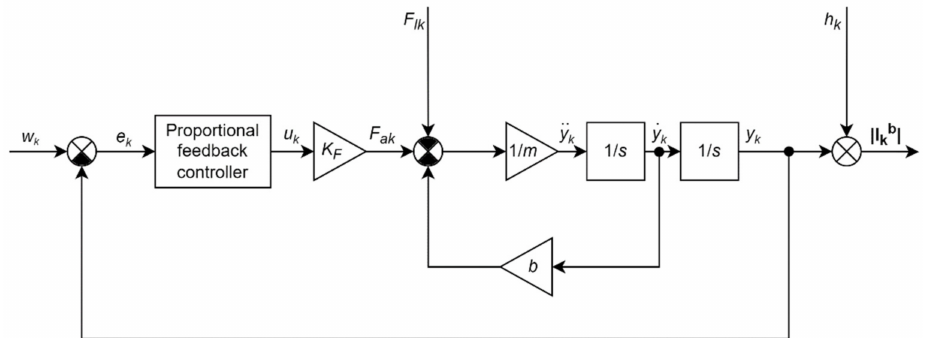
Figure 7. Feedback control loop for a single linear actuator.